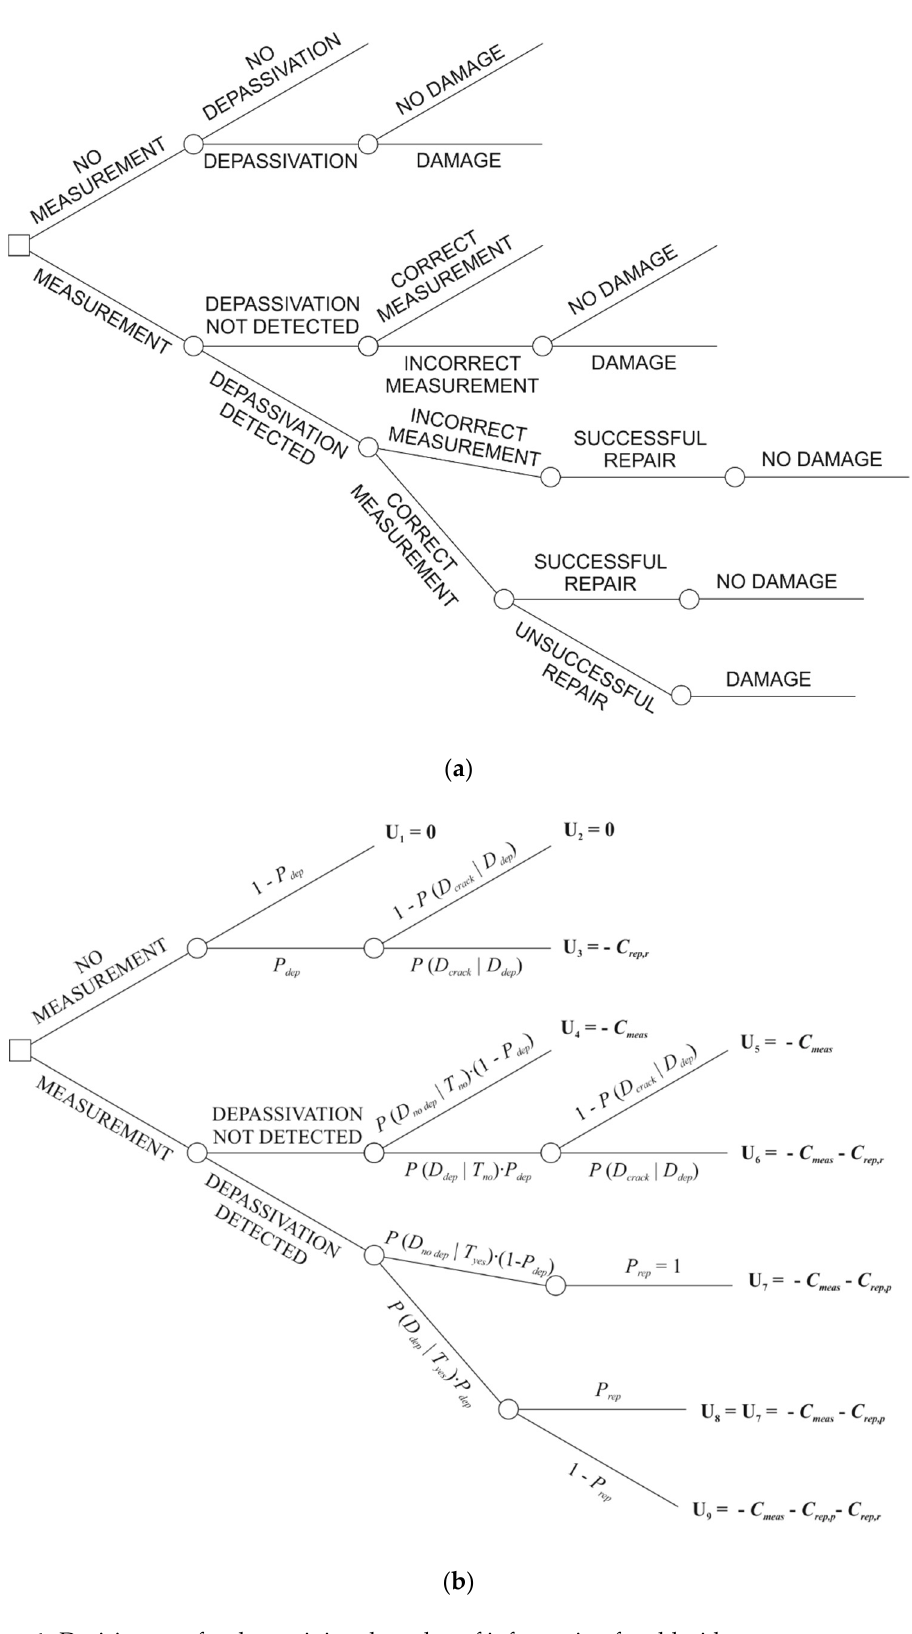
Figure 1. Decision tree for determining the value of information for chloride measurements, where: ( a ) represents the events in the decision tree; ( b ) represents the probabilities of occurrence and associated costs.